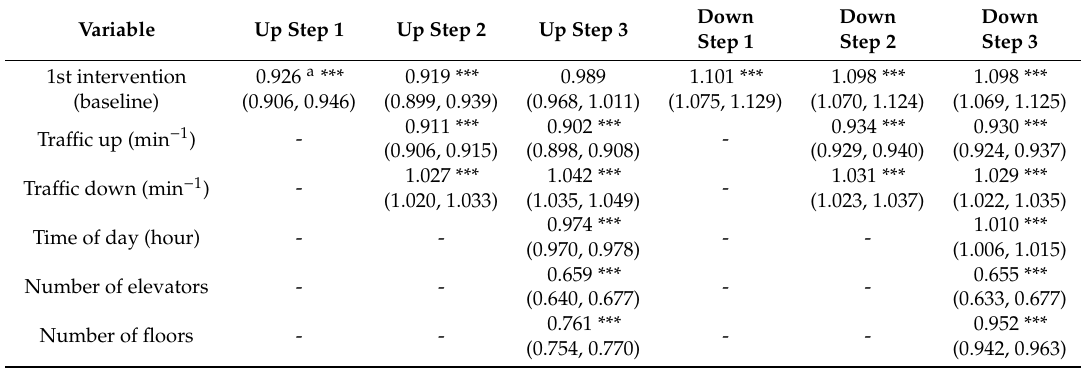
Table 2. Summary of the e ff ects of variables on stair use in the UK during the first intervention phase.